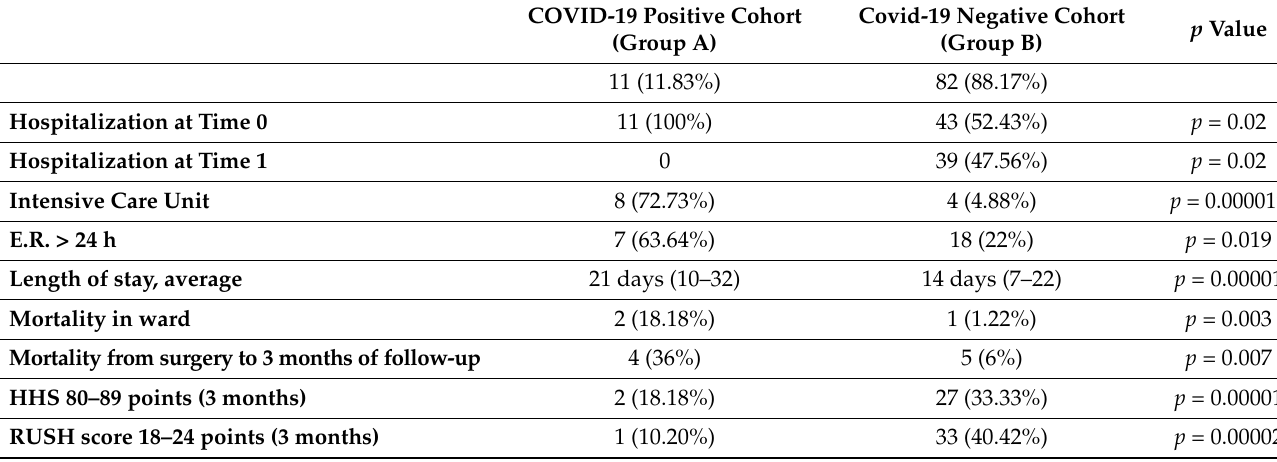
Table 2. Positive cohort with the negative